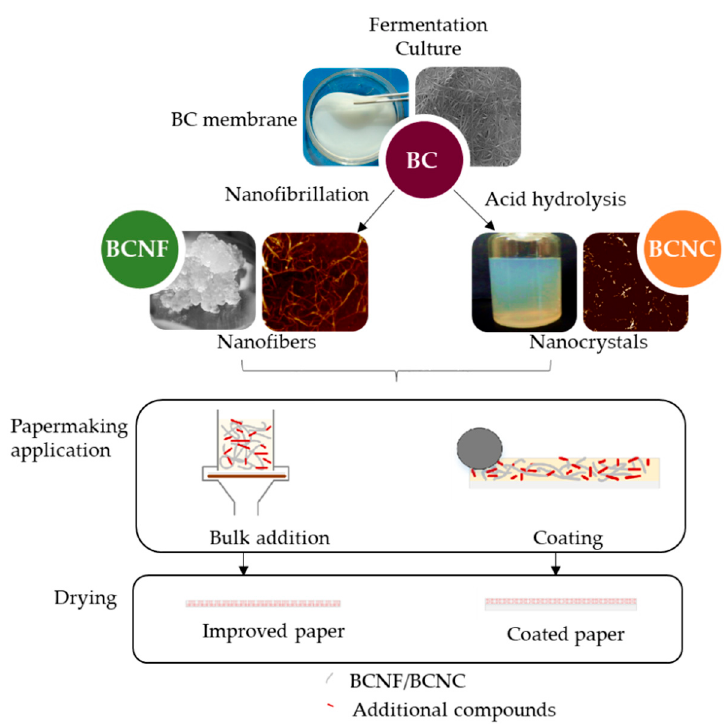
Figure 1. Alternatives for BC dispersion (BCNF: BC nanofibers; BCNC: BC nanocrystals).